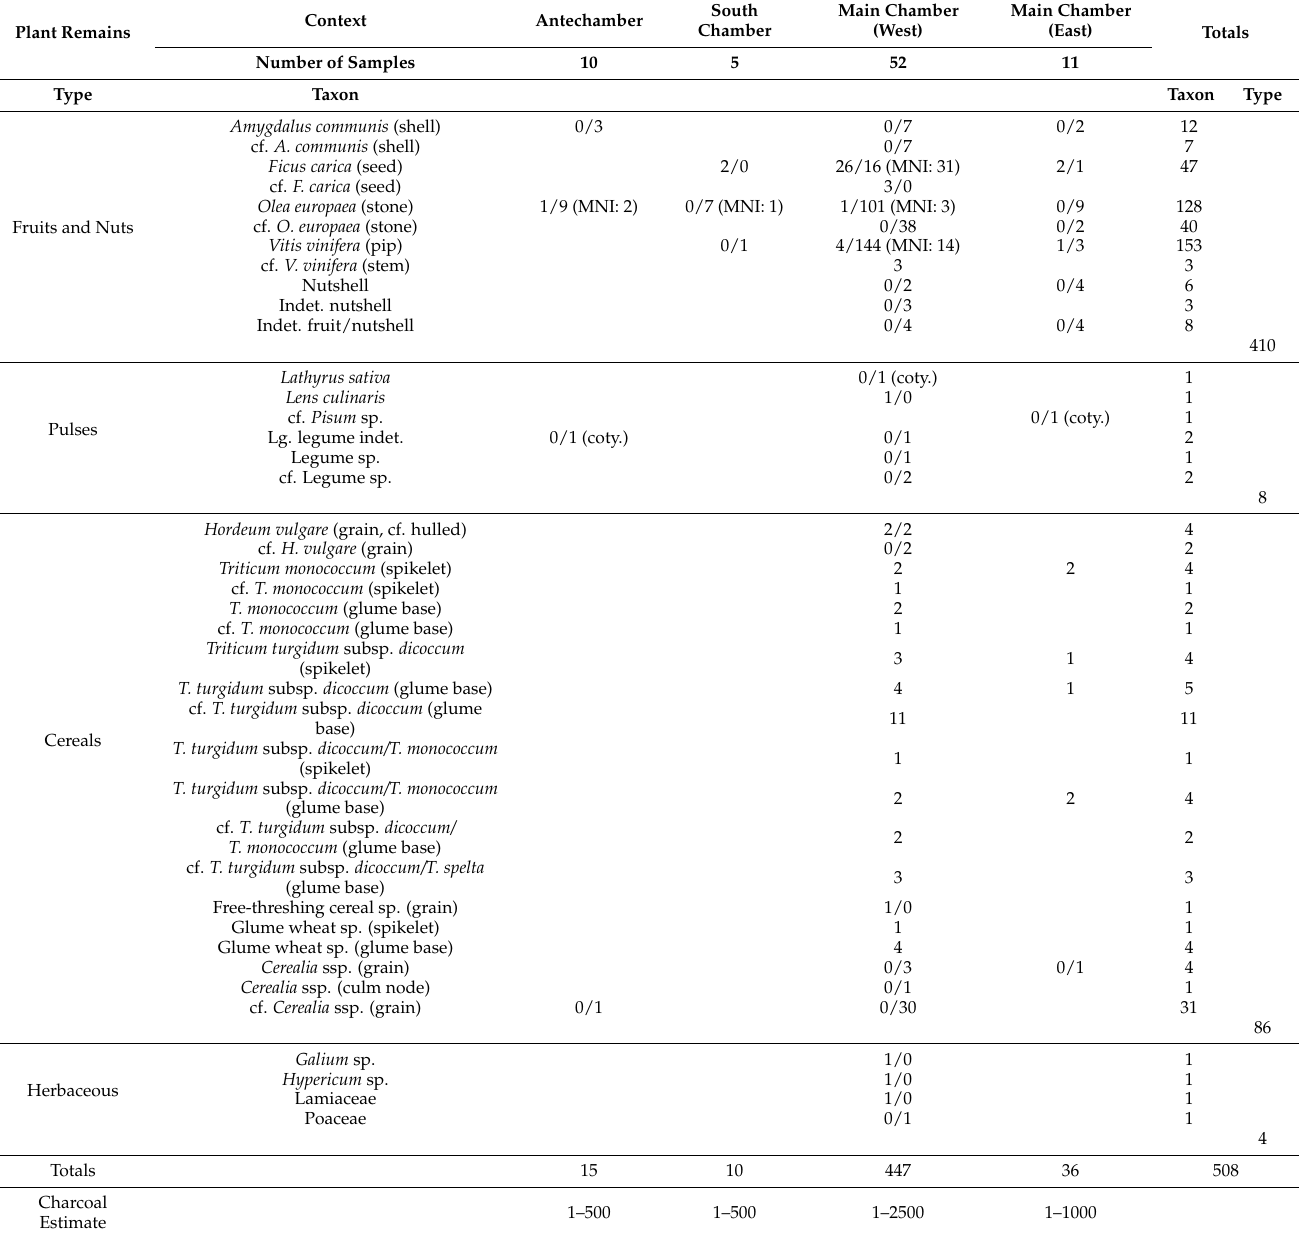
Table 3. Archaeobotanical data for Knossos Anetaki–Fetish Shrine